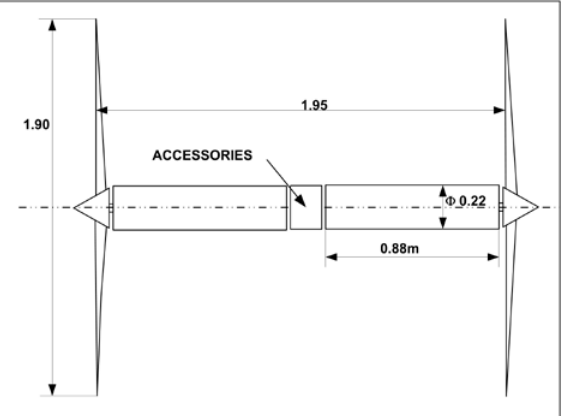
Fig. 7. Propeller with folding blades for motor glider application. From (Tervamaki